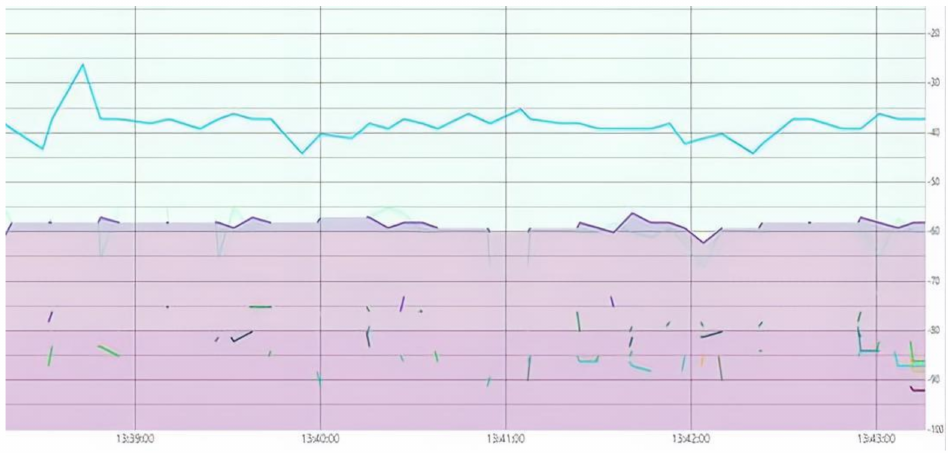
Figure 3. RSSI- based interference